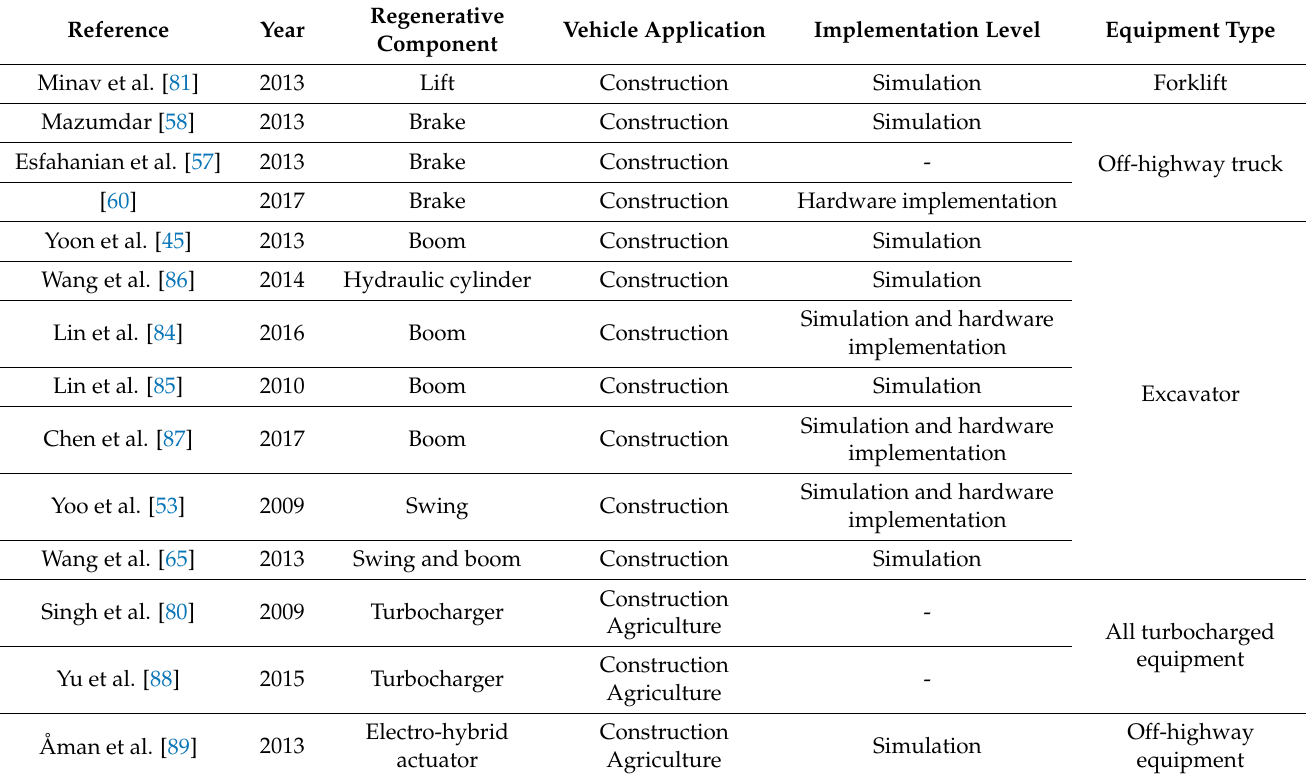
Table 7. Energy recovery techniques in reviewed literature for equipment types of